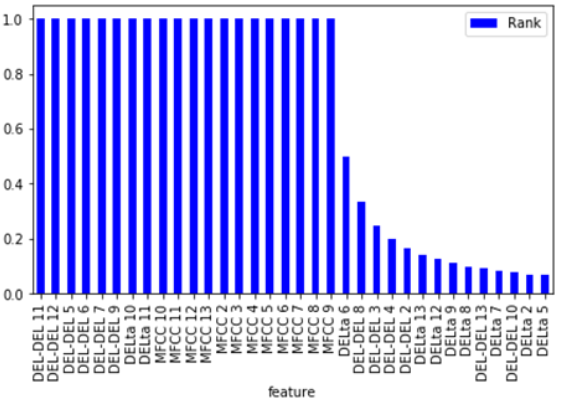
Figure 5. SVM-recursive feature elimination (RFE) ranking performance of the 34 uncorrelated features. As shown, the features with the most squared weights are assigned a rank of value 1 while the features with least squared wights rank between 0 and